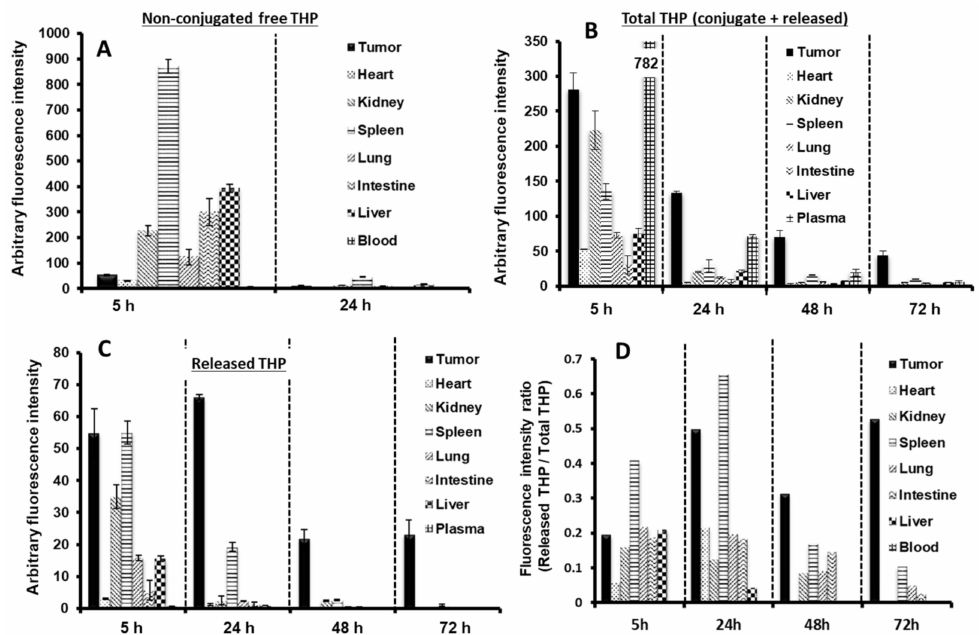
Figure 6. Body distribution of P-THP. ( A ) Free pirarubicin (THP) was administered at 10 mg of THP per kg equivalent. ( B ) and ( C ) Profile of P-THP administered at 10 mg of THP per kg equivalent into S-180 tumor-bearing mice. At the indicated time periods, mice were anesthetized and tissues were collected. ( B ) Total THP content and ( C ) released free THP content in each tissue sample were measured using HPLC. Values are expressed as the mean ± S.E. ( n = 3). ( D ) Ratio of free THP to total THP in each tissue. The fluorescence intensity of the free THP was divided by the fluorescence intensity of the total THP. Adapted from ref.